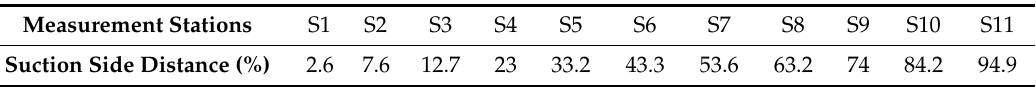
Table 4. Measurement stations of the DCA suction side as a percentage of the suction side length